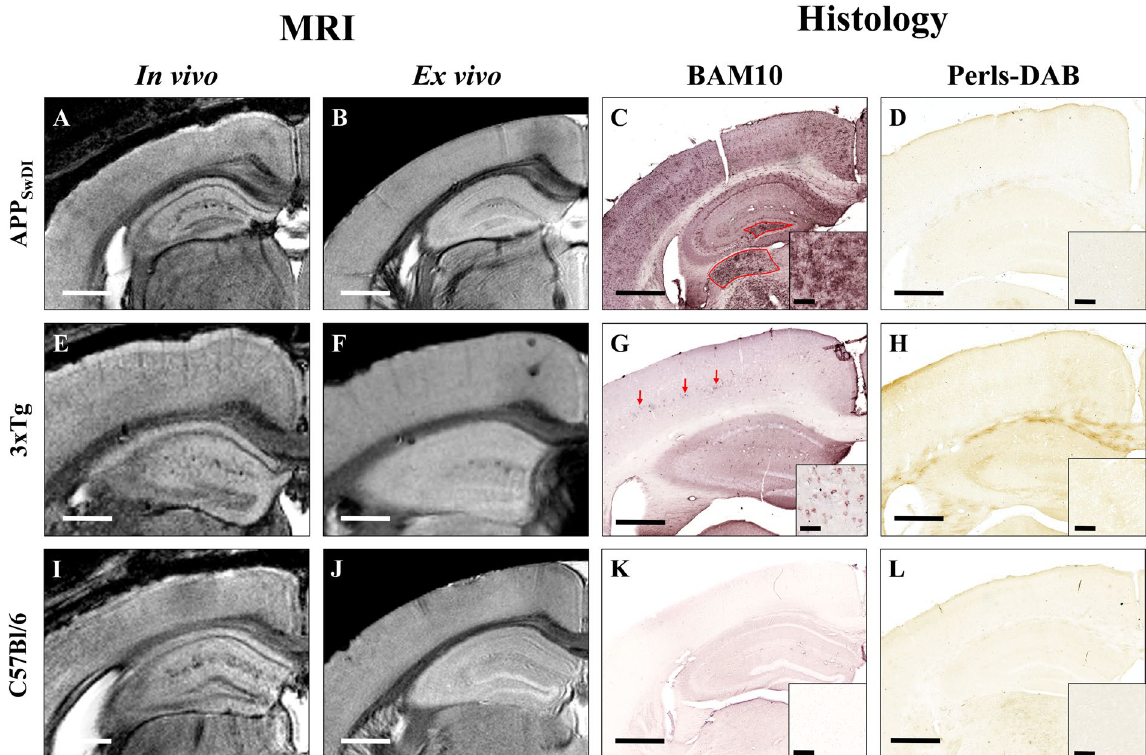
Figure 2. Comparison between detection of amyloid plaques by Gd-stained MRI and immunohistochemistry in APP SwDI , 3xTg, and C57Bl/6 amyloid-free mice. Gd-stained in vivo (column 1) or ex vivo (column 2) MR images were registered with β -amyloid (BAM10, column 3) and iron-stained (Perls-DAB, column 4) histological sections in APP SwDI ( A–D ), 3xTg ( E–H ) and C57Bl/6 amyloid-free ( I–L ) mice. Inserts in columns 3 and 4 display typical plaques for each strain. MR images of APP SwDI mice do not present with hypointense spots ( A , B ). BAM10 and iron staining show large diffuse A β -positive lesions ( C , red shape) devoid of iron deposits ( D ). 3xTg mice do not present with hypointense spots on MR images ( E , F ). BAM10 and iron staining show intracellular A β deposits ( G , red arrows) devoid of iron ( H ). In C57Bl/6 amyloid-free mice, no hypointense spots on MR images ( I , J ) or amyloid plaques on BAM10 sections ( K ) are detected. Scale bars: 500 µ m for main images and 50 µ m for